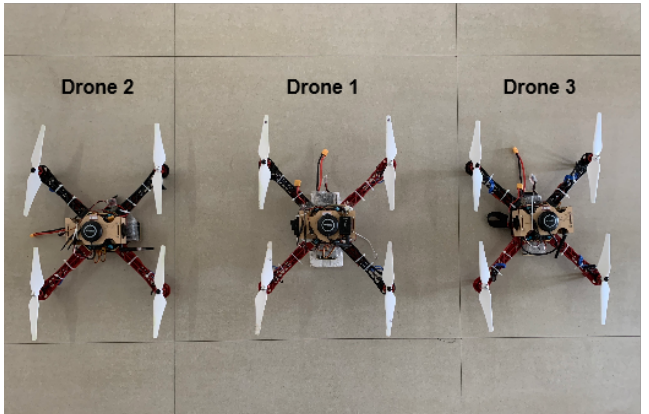
Figure 7. Drone setup with a Pixhawk (PX4) flight controller in the center and an embedded unit and camera unit situated beneath the